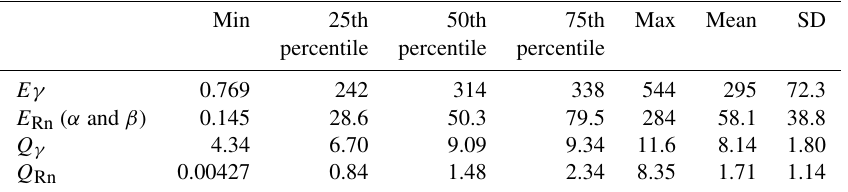
− 3 s − 1 were derived from Rn ) in cm